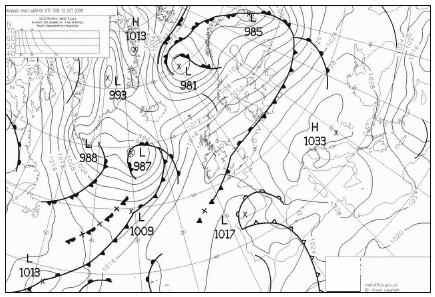
Figure 3: Synoptic map for 12 October